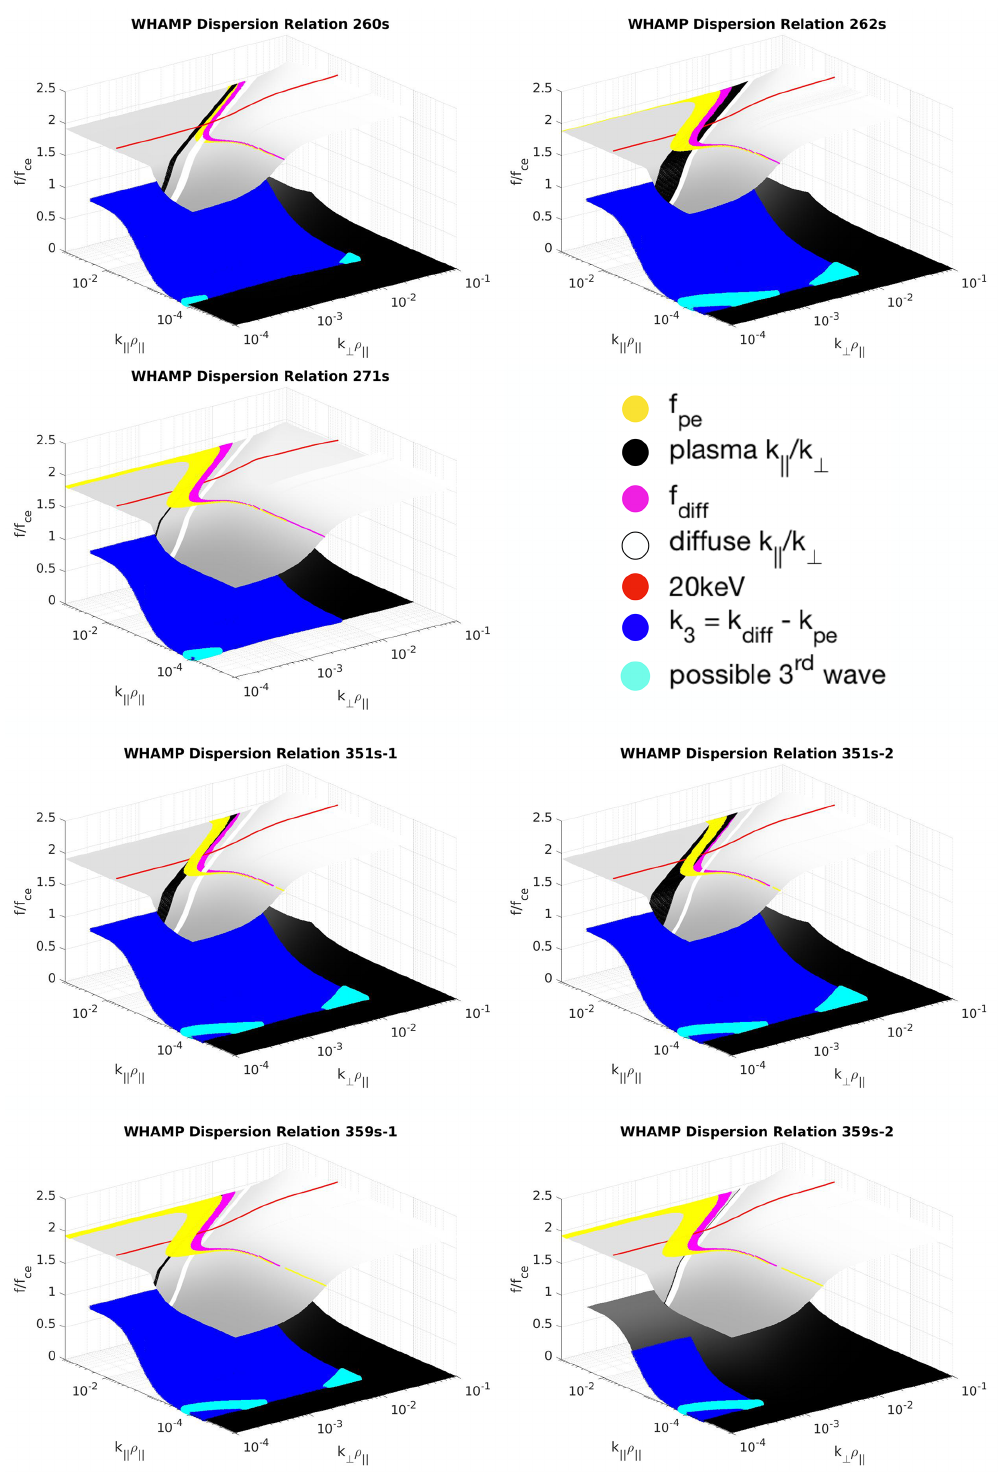
Figure 7. WHAMP dispersion surfaces for Langmuir bursts labeled in Figs. 2–4, with k || /k ⊥ ratios inferred from the maximum E || /E ⊥ in Table 1 plotted as black for the plasma line and white for the diffuse feature. The yellow and pink areas indicate where the surface matches the frequency of the plasma line and diffuse feature, respectively. Where these intersect defines the range of possible k vectors for each wave. Assuming wave–wave interaction, kinematic equations imply a range of k vectors for the possible third wave plotted in dark blue on the whistler–LH surface and the matching frequency of the third wave plotted in light